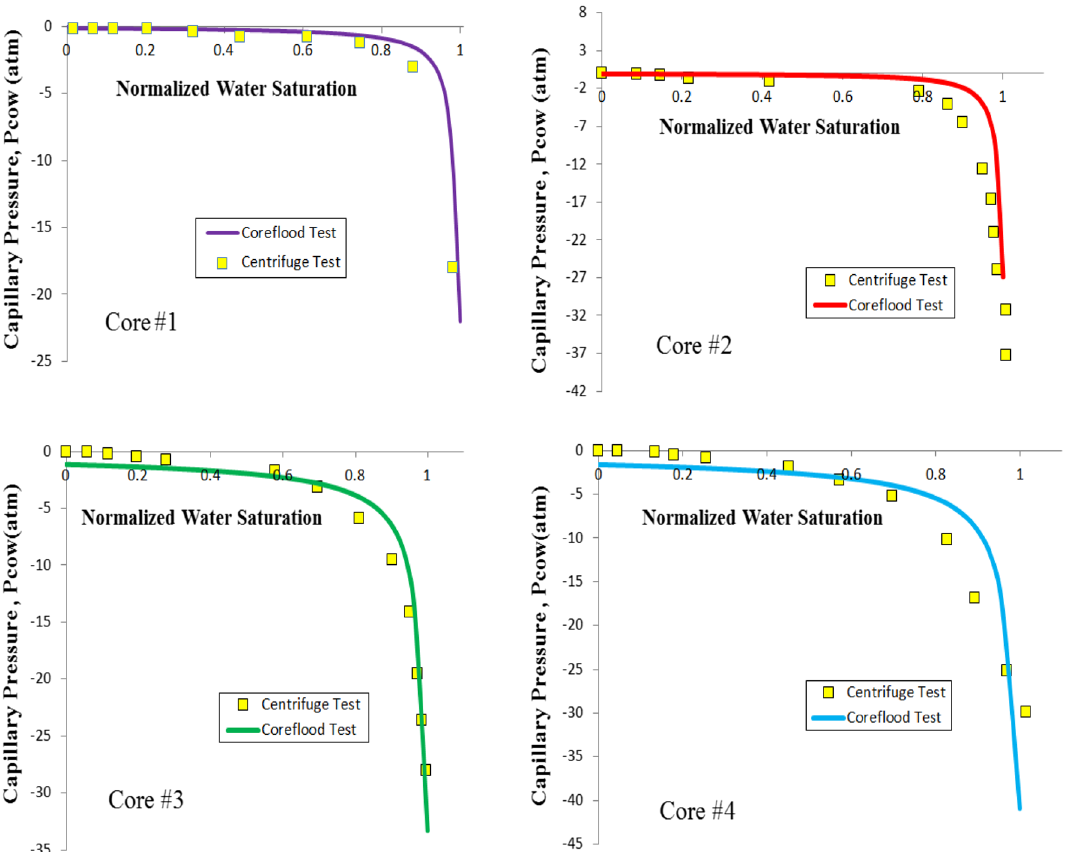
Fig. 6 Oil–water capillary pressure versus normalized water saturation obtained from the centrifuge test and that resulting from history matching of the water injection tests